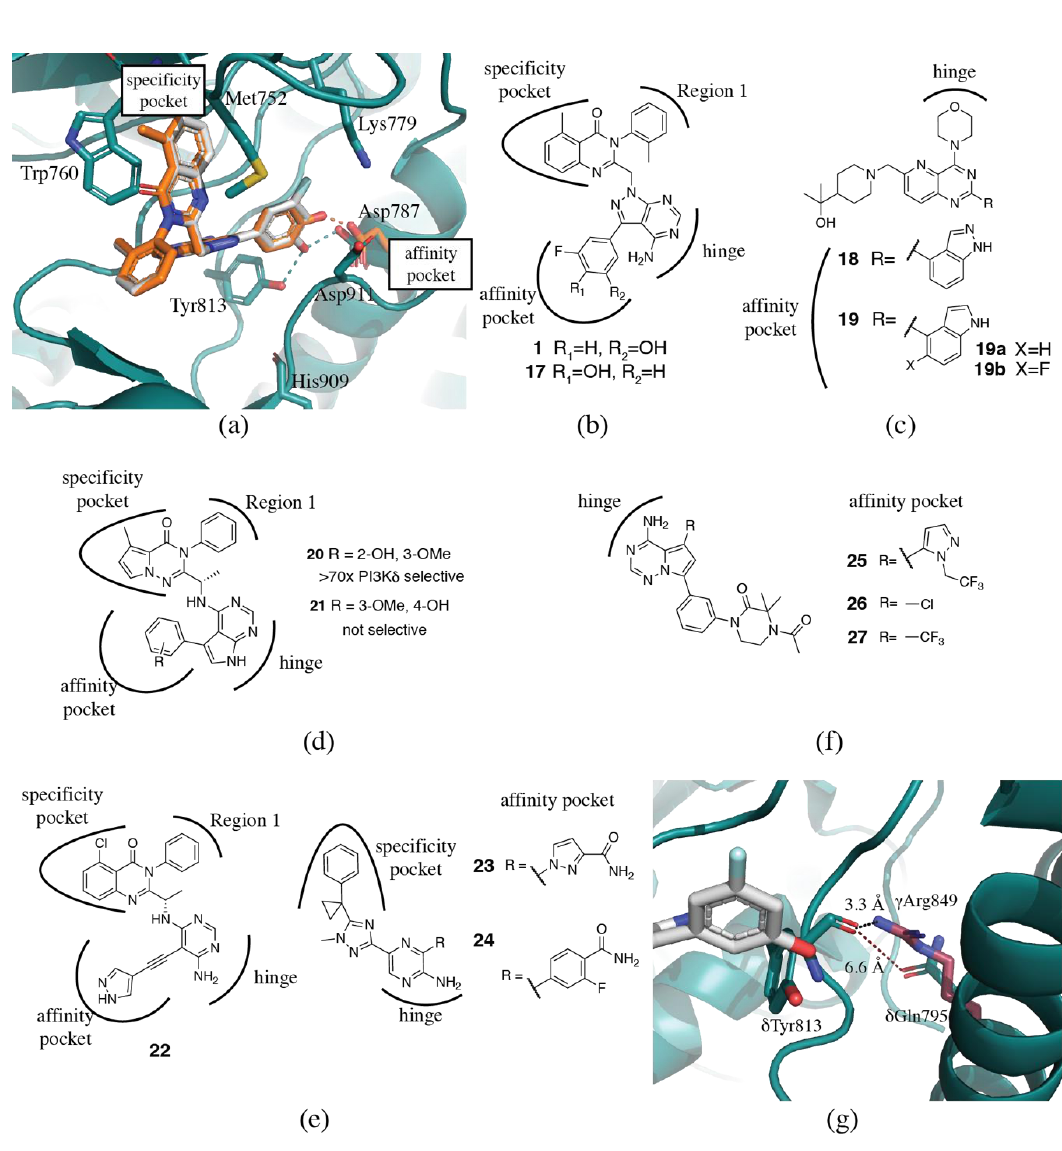
Figure 4. Modifications in the affinity pocket. ( a ) Impact of subtle differences in the affinity pocket. meta -substituted fluorophenol 1 (white, PDB ID 2WXG) can form hydrogen bonds with δ Asp787 and δ Tyr813 (indicated with teal dashed lines), while ortho -substituted fluorophenol 17 (orange, PDB ID 2WXH) can only form hydrogen bonds with δ Asp787 (indicated with orange dashed lines) ( b ) Structures of 1 and 17 ( c ) Structures of inhibitors with indole and indazole affinity pocket binding motifs ( d ) Structures of inhibitors 20 – 21 ( e ) Structures of inhibitors 22 – 24 ( f ) Structures of inhibitors 25 – 27 ( g ) Rationalizing differences in affinity pocket selectivity. γ Arg849 forms a hydrogen bond with the backbone of γ Tyr867 (equivalent to δ Tyr813), restricting movement in the affinity pocket, while the side-chain of δ Gln795 is too short to make the same interaction. Distances are marked with dashed lines. The fluorophenol moiety of 1 bound in the affinity pocket is shown for reference.